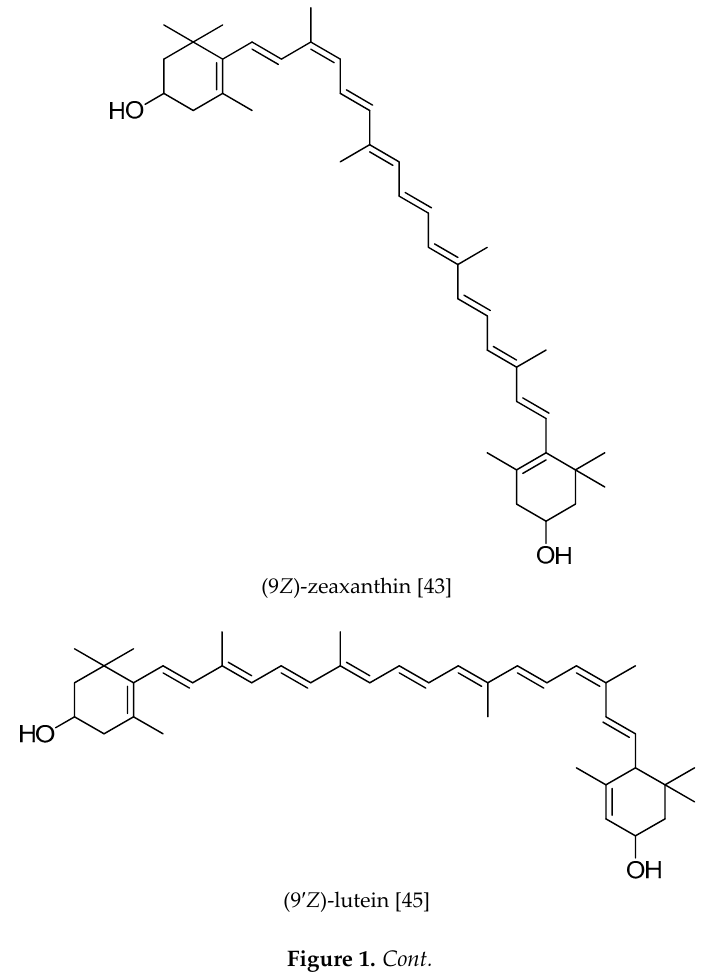
Figure 1 . Cont . Figure 1.